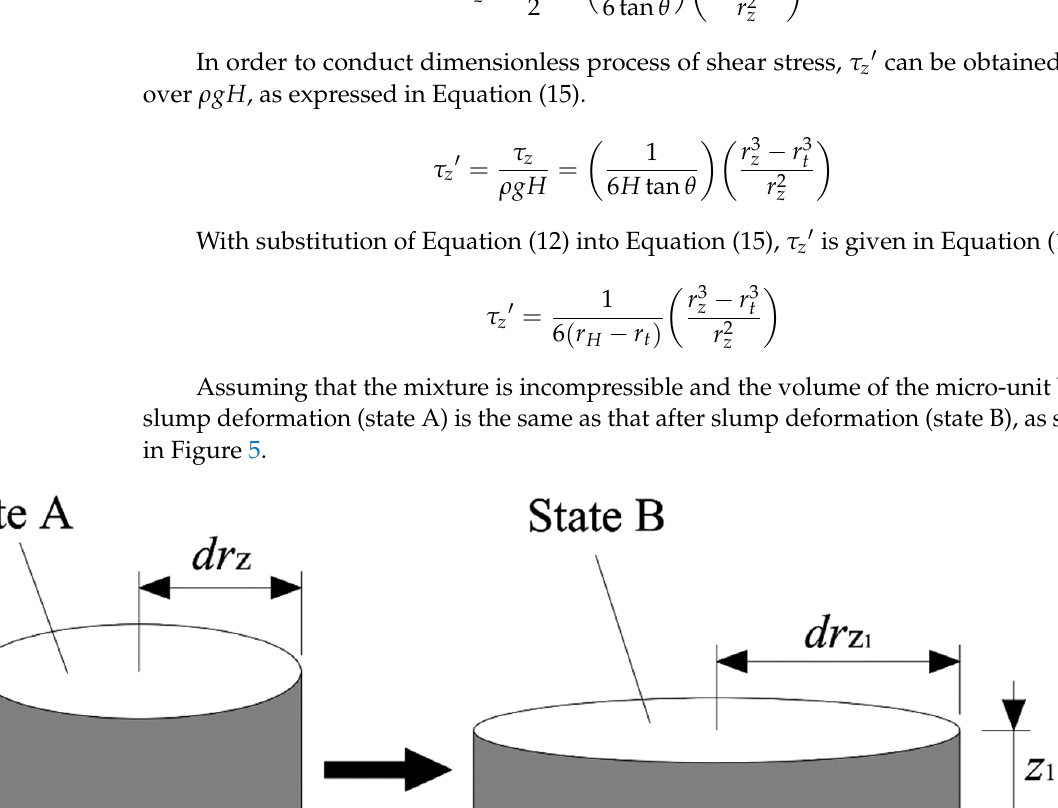
Figure 5. Schematic of micro-unit variation (from state A to state B). The volume of the micro-unit did not change during slump deformation, so the corresponding relationship can be expressed as Equation (17):